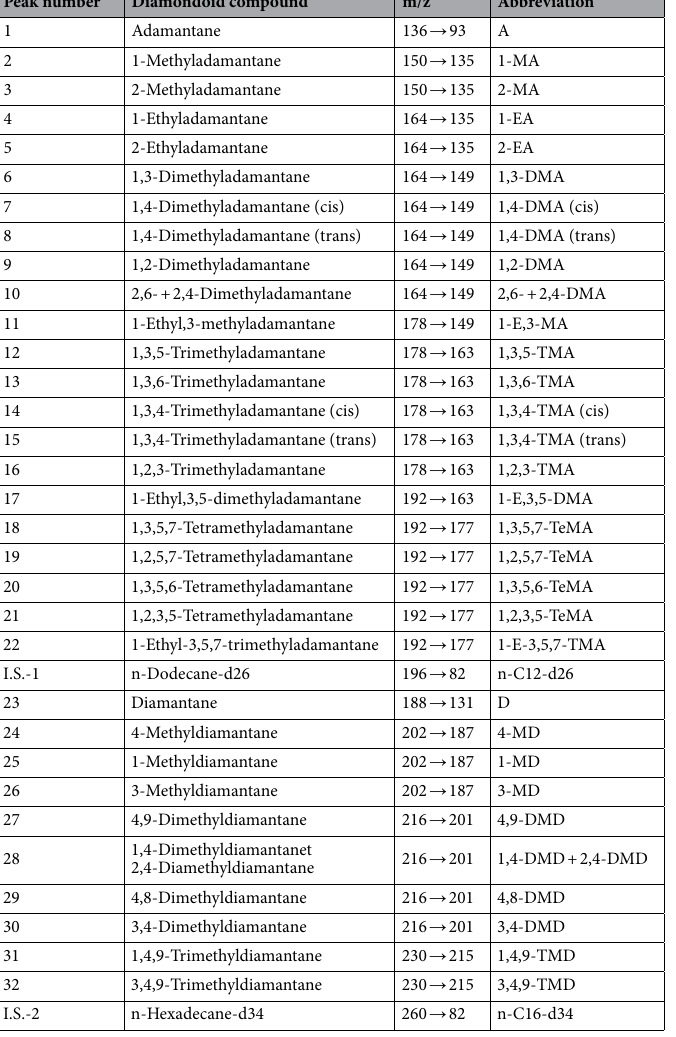
Table 1. The detected diamondoid compounds in this